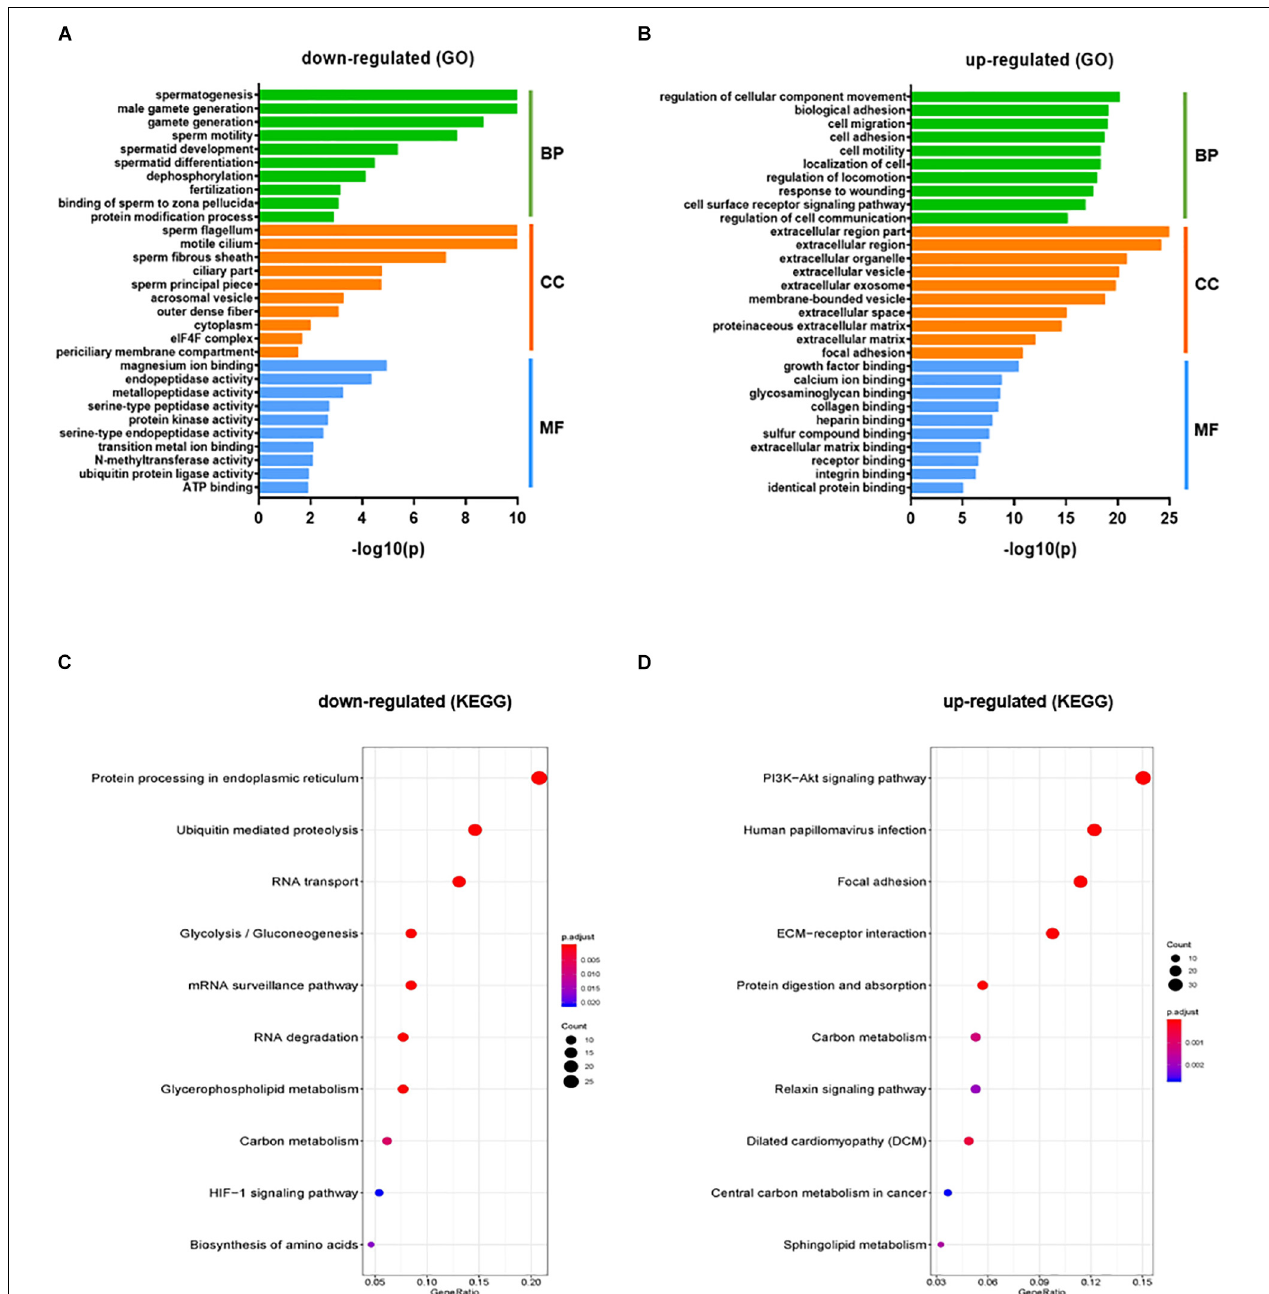
FIGURE 2 | GO and KEGG pathway enrichment analysis of DEGs. GO functional analysis (Top 10 GO terms) for down-regulated DEGs (A) and up-regulated DEGs (B) in KI vs WT mice were grouped into different functional categories: biological process (BF), cellular component (CC) and molecular function (MF). (B) Representative dot plot of top 10 significantly ( P < 0.05) enriched KEGG pathways for down-regulated (C) and up-regulated genes (D) . The x -axis represents gene ratio = count/set size. Dot size represents the number of genes and the color bar represents the